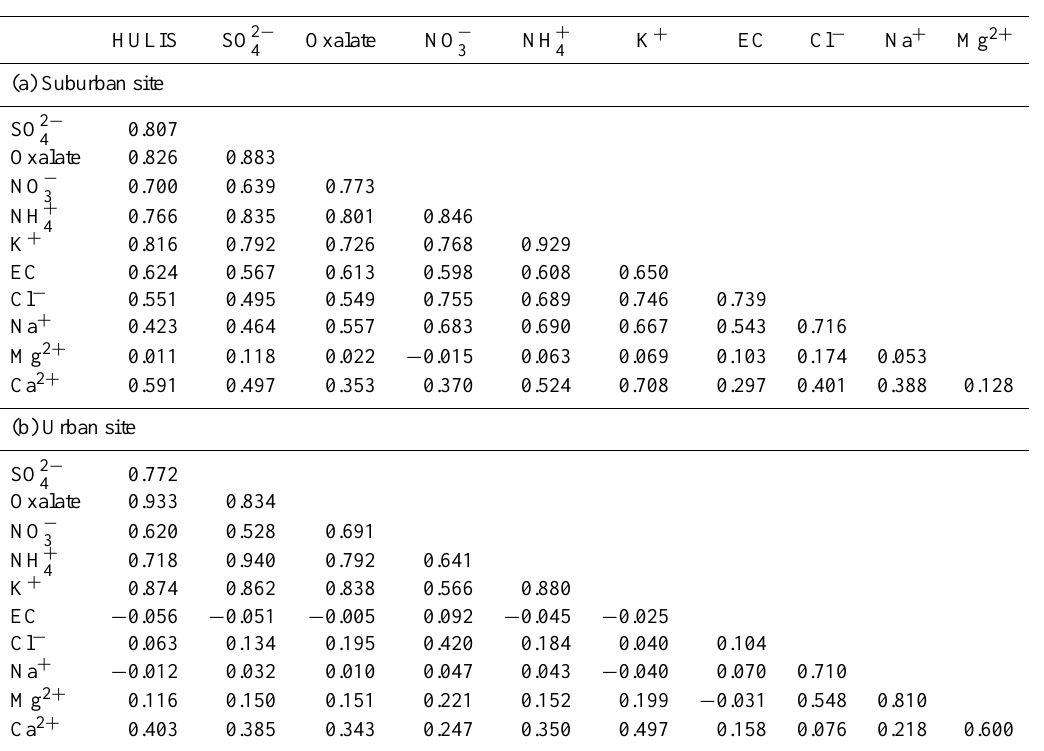
Table 2. Correlation coefficient ( R ) matrix among HULIS and the measured major constituents in PM 2 . 5 at (a) the suburban site and (b) the urban